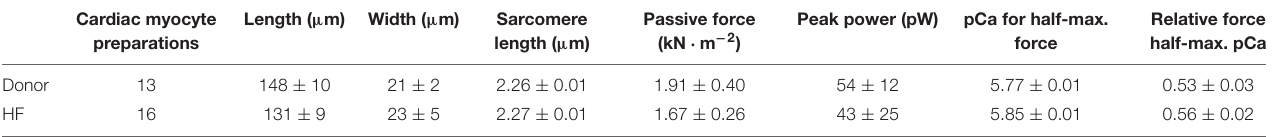
TABLE 1 | Human permeabilized cardiac myocyte preparations.